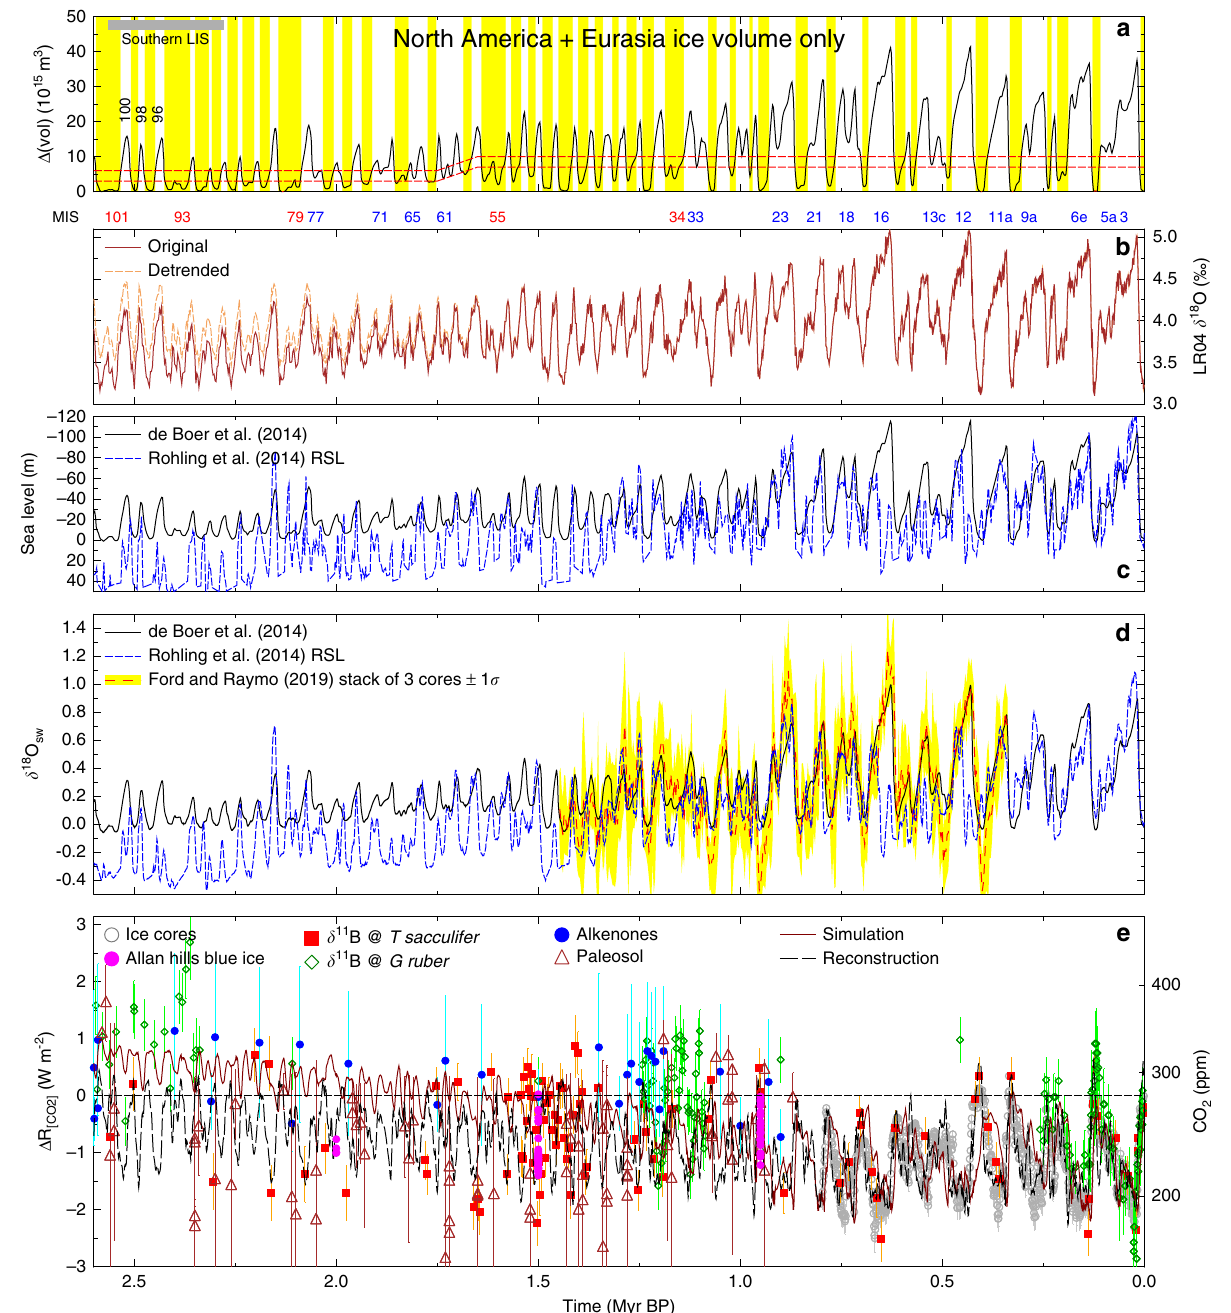
Fig. 4 Knowns and unknowns of Quaternary climate. a Ice volume change in North America and Eurasia used to de fi ne interglacials (see caption to Fig. 2a for details). Earliest southern advance of the Laurentide ice sheet to 39°N in Missouri marked by grey horizontal bar 46 . Prominent fi rst large glaciations in the Quaternary labelled with their MIS 100, 98, 96. Marine isotope stages (MIS) in obliquity cycles without a new interglacial are labelled for skipped terminations (blue), or continued interglacials (red). b LR04 benthic δ 18 O stack 4 , original and as detrended in T17. c Sea level and d δ 18 O sw of different studies 29,48,49 . e Atmospheric CO 2 and its radiative forcing of Δ R ½ based on ice cores 37 , Allan Hills Blue Ice 34 , various marine proxies ( δ 11 B from either CO 2 (cid:2) T sacculifer 10,12,57 or G ruber 11,58 – 61 , alkenones 58,62,63 ) paleosol 33 , model simulation 9 and data-based reconstruction 38,39 . Error bars show 1 σ